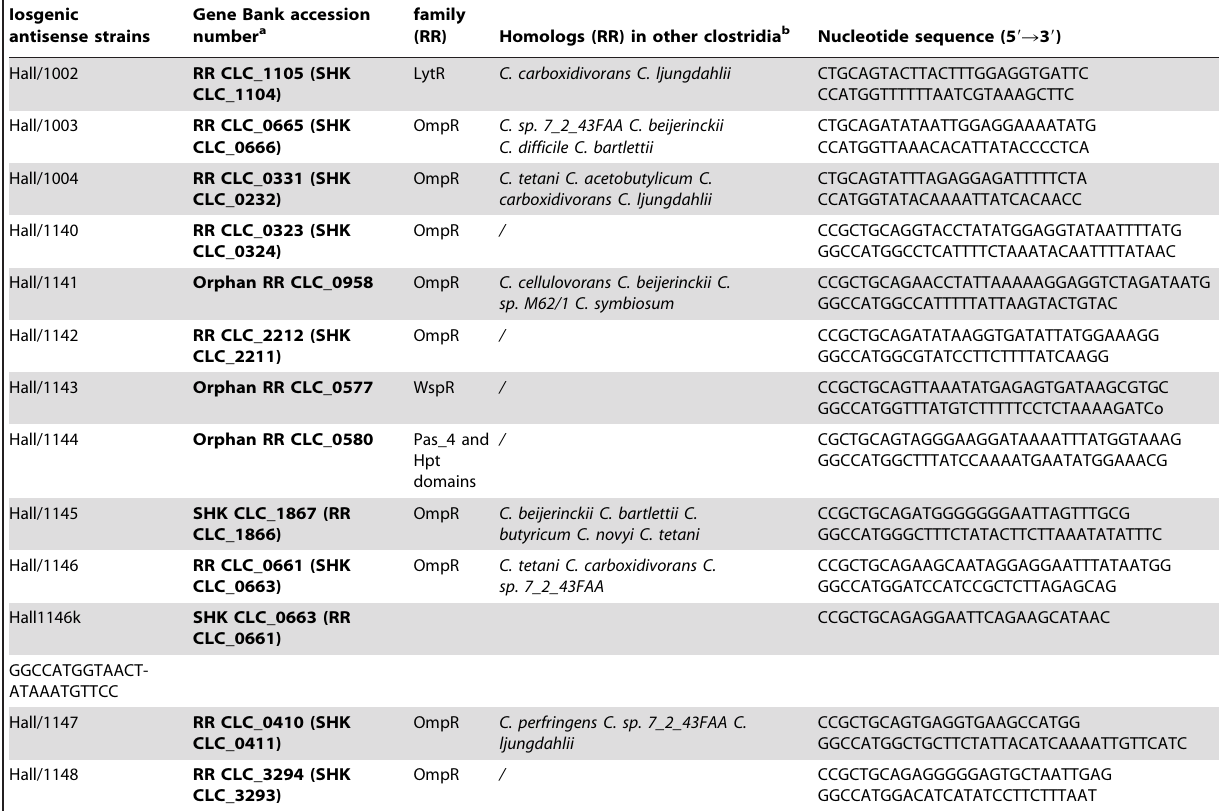
Gene Bank accession number a